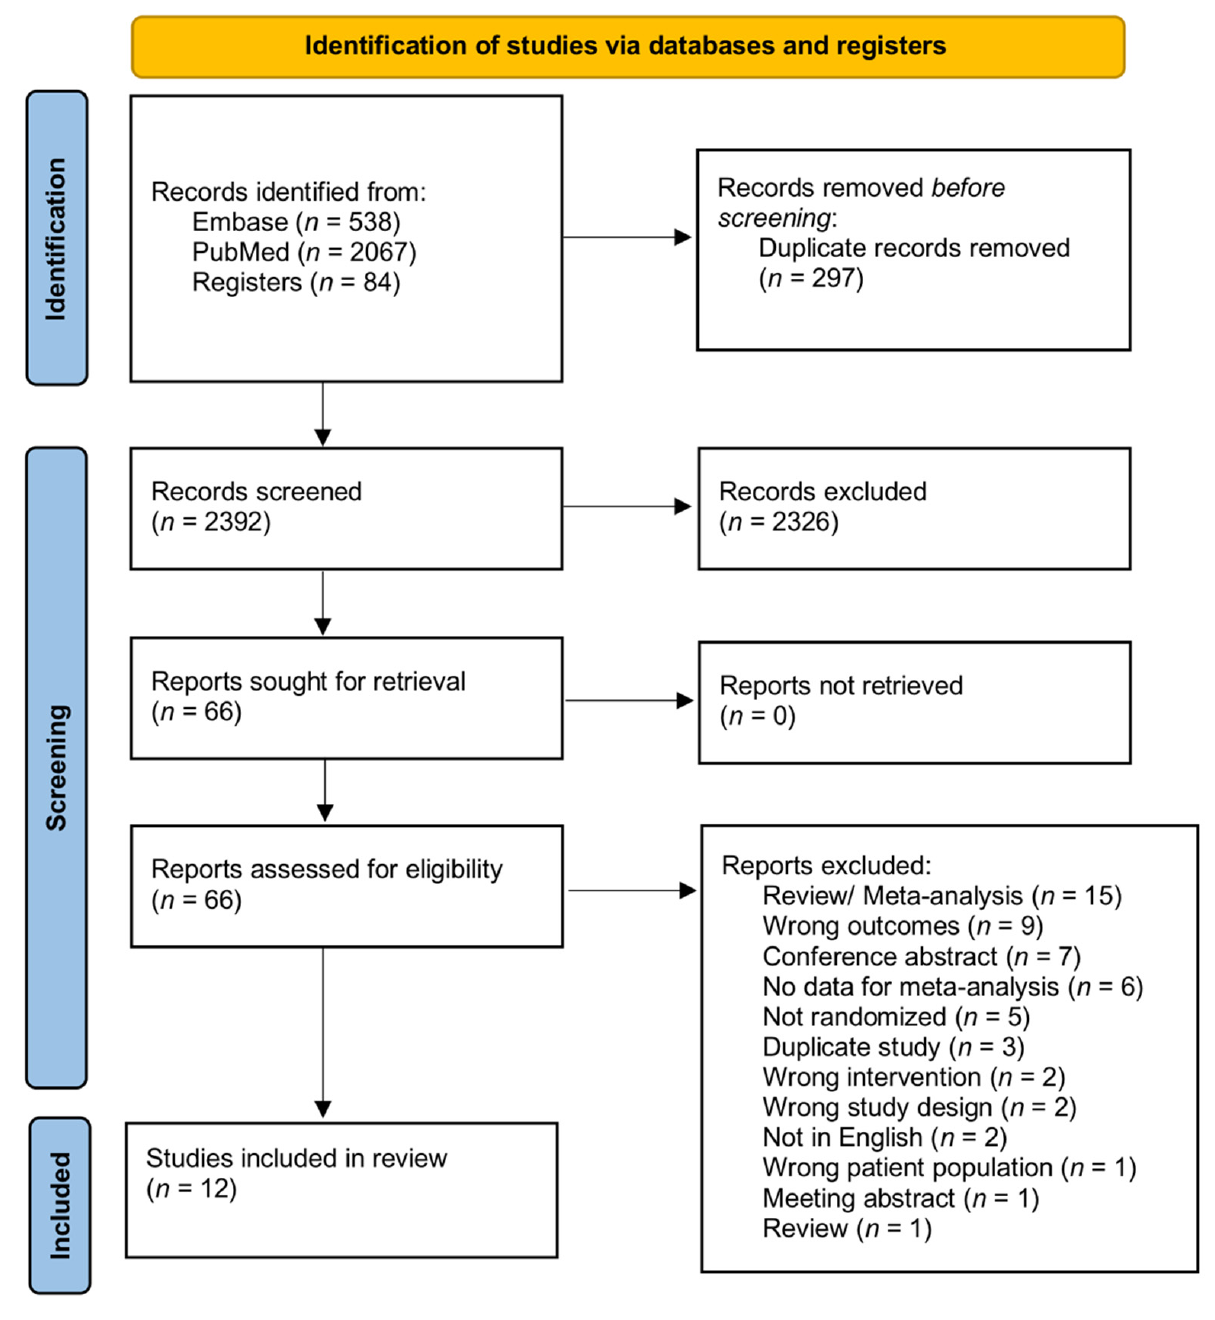
Figure 1. PRISMA diagram of this study.